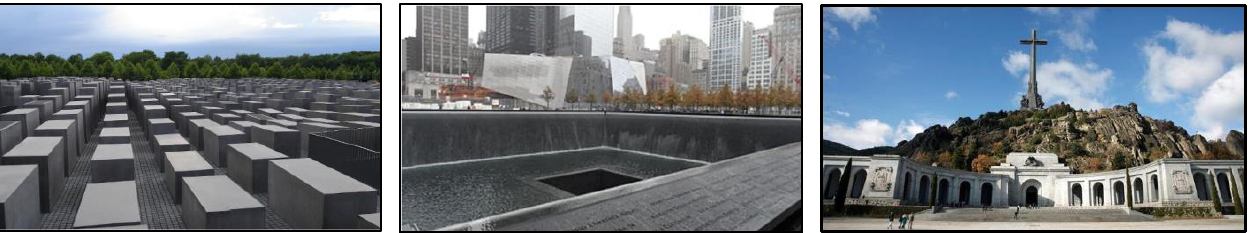
Figure 1. Memorial to the Murdered Jews of Europe (Berlin, 2005) ( left ), National 9/11 Memorial (NYC, 2011) ( center ), and Valley of the Fallen (El Escorial, 1959) ( right